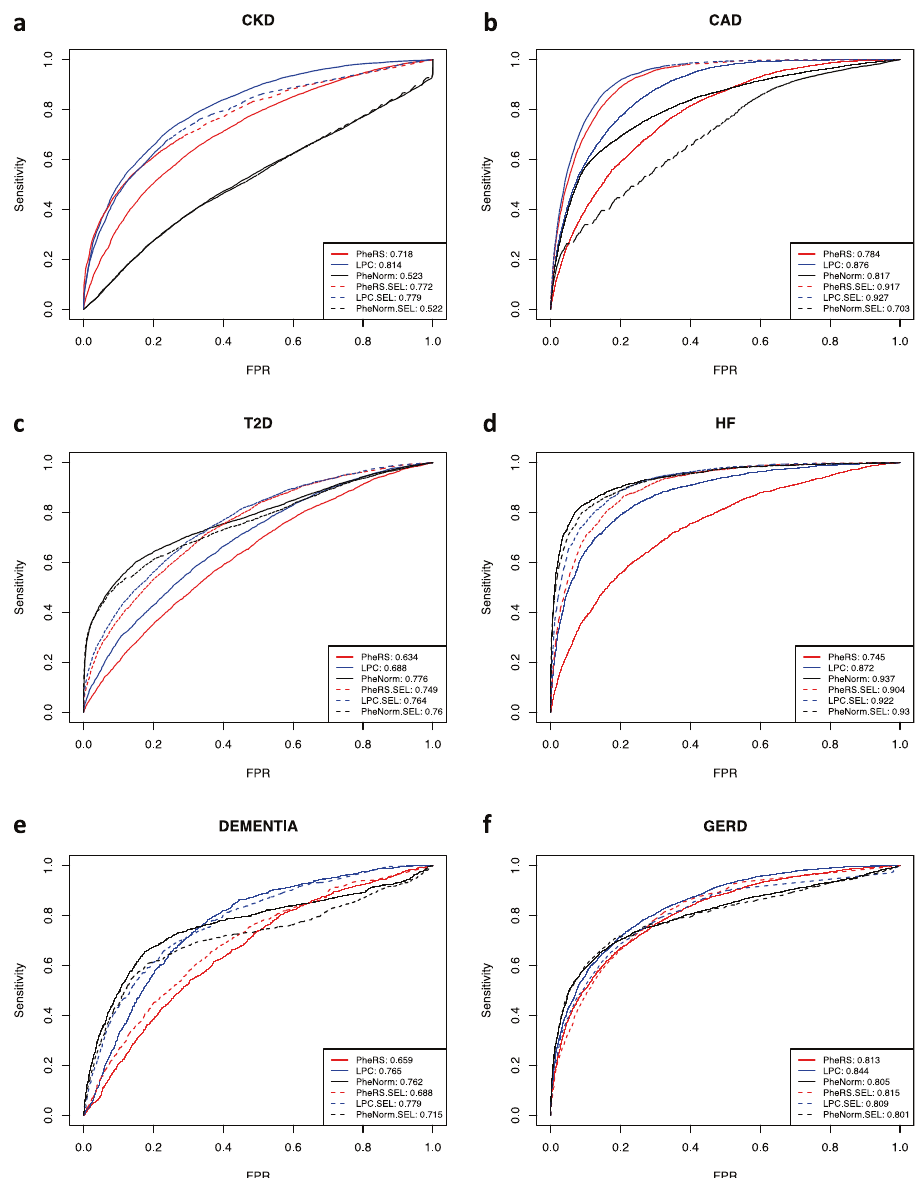
Fig. 1 ROC curves cases vs. controls for six phenotypes. ROC curves of six quantitative disease risk scores along with their AUROCs for a CKD (cases including G1, G2, G3a/b, and G4 stages), b CAD, c T2D, d HF, e Dementia, and f GERD. Quantitative disease risk scores are derived based on all phecodes (PheRS, LPC, and PheNorm), or pre-selected feature phecodes (PheRS.SEL, LPC.SEL, and